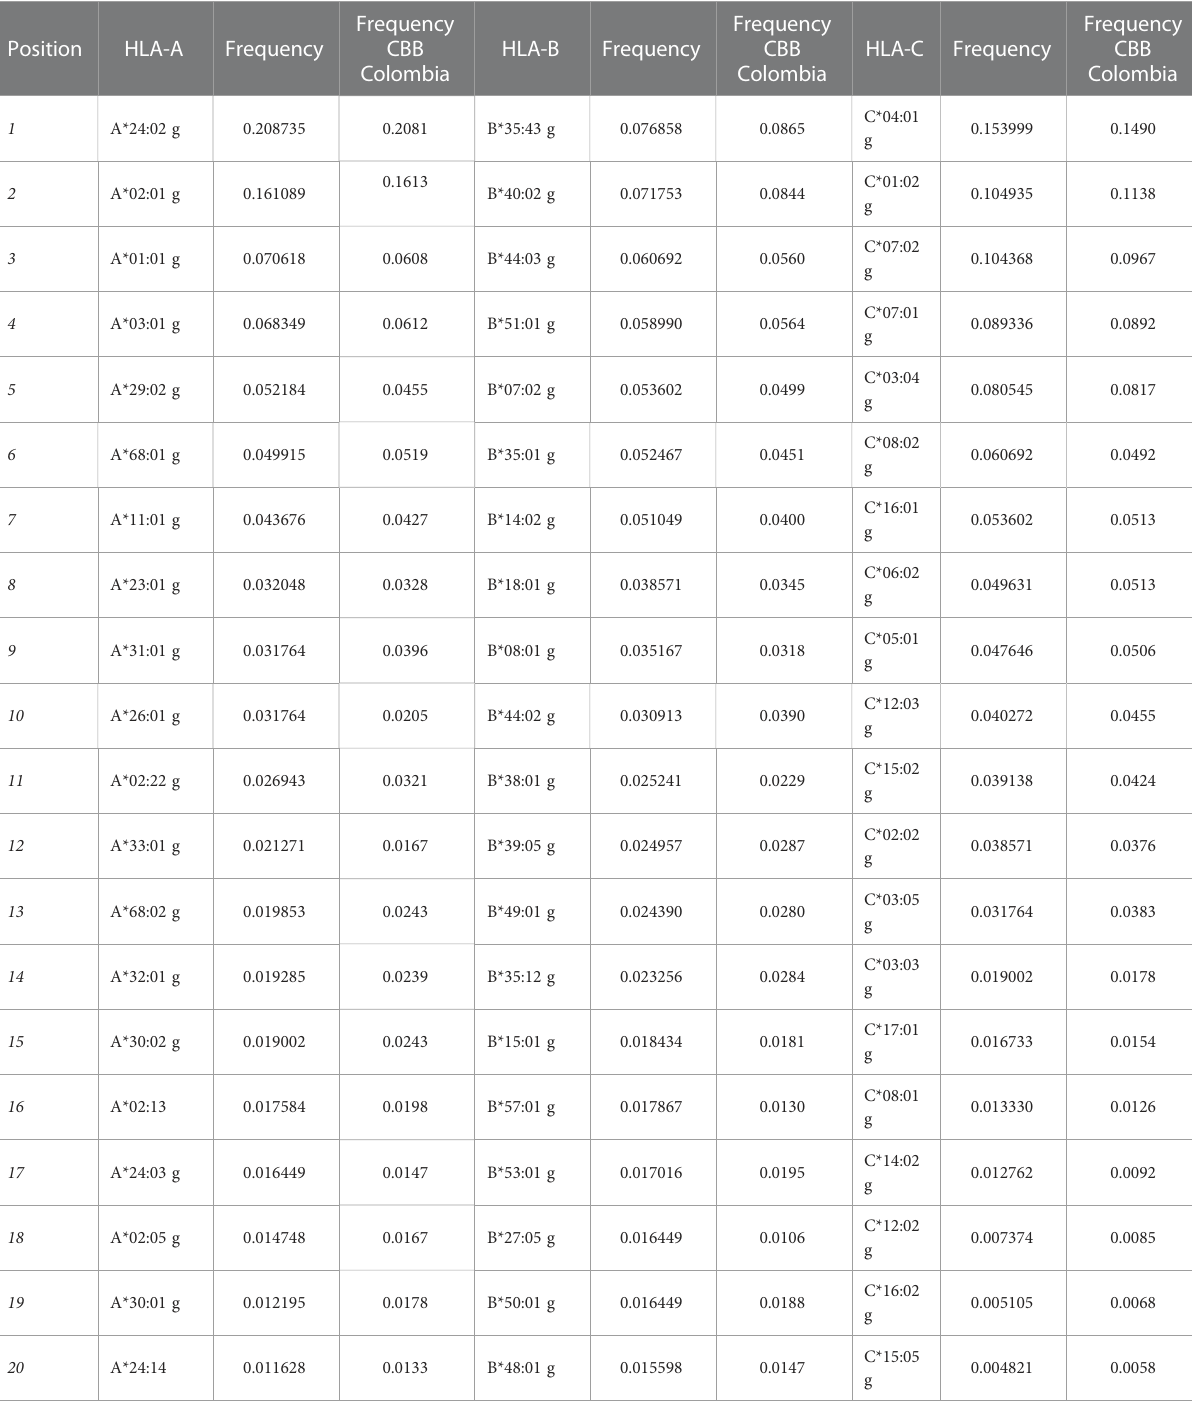
TABLE 1 List of the 20 most frequent alleles for HLA class I loci for the population in the study and a comparison with allele frequencies reported by the Colombian UCB